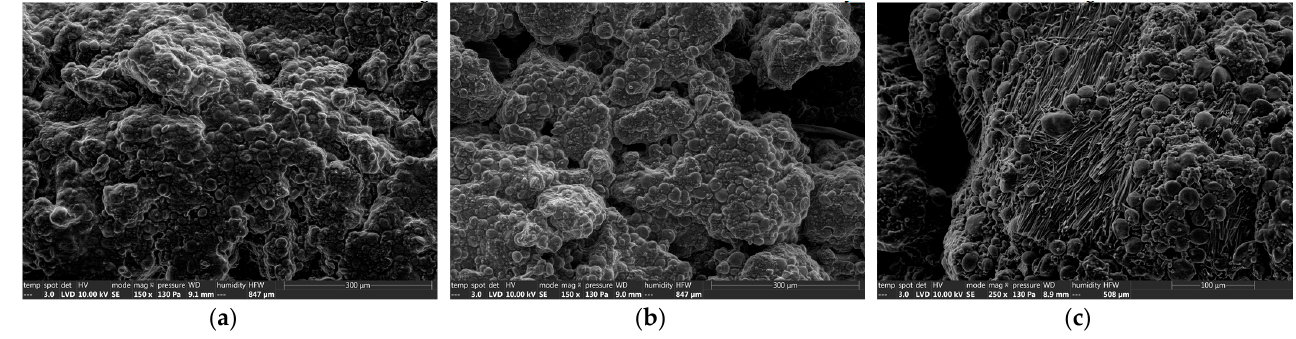
Figure 3. Environmental Scanning electron microscope (ESEM) analyses of the different loose doughs. ( a ): control dough exhibiting smooth starch granules and sucrose crystals embedded in a compact matrix, × 150, ( b ): maltitol dough exhibiting smooth starch granules and maltitol crystals embedded in a powdery matrix, × 150, ( c ): sorbitol dough magnified at × 250 to reveal localized sorbitol flakes among smooth starch granules embedded in a slightly powdery matrix.